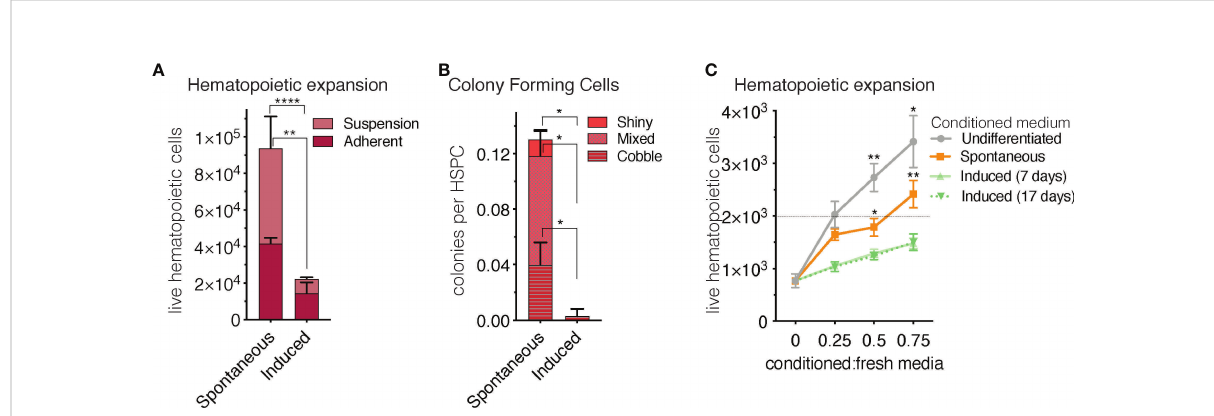
FIGURE 6 Short-term co-culture of OP9-adipocytes with hematopoietic stem and progenitor cells favours hematopoietic expansion in the spontaneous condition. (A) Total hematopoietic cell expansion of 2000 initial HSPCs after seven days in co-culture (including cells in adherent and cells in suspension) is signi fi cantly higher (p < 0.0001) when hematopoietic stem and progenitor cells, HSPCs, (cKit + Lin - Sca1 + , KLS) are co-seeded with spontaneous- compared to induced OP9 adipocytes. (B) The colony forming capacity of HSPCs seeded with spontaneous OP9 adipocytes is signi fi cantly higher (P < 0.05) than when cultured with induced OP9 adipocytes. (C) , Total hematopoietic expansion (in the absence of stroma) after two-day co-culture of 2000 HSPCs in conditioned medium from OP9 cultures comprising increasing ratios of conditioned-to-fresh media. ****P < 0.0001, **P < 0.01, *P < 0.05 by Bonferroni ’ s multiple comparisons test. Error bars represent mean ± s.d. (n = 3 biological